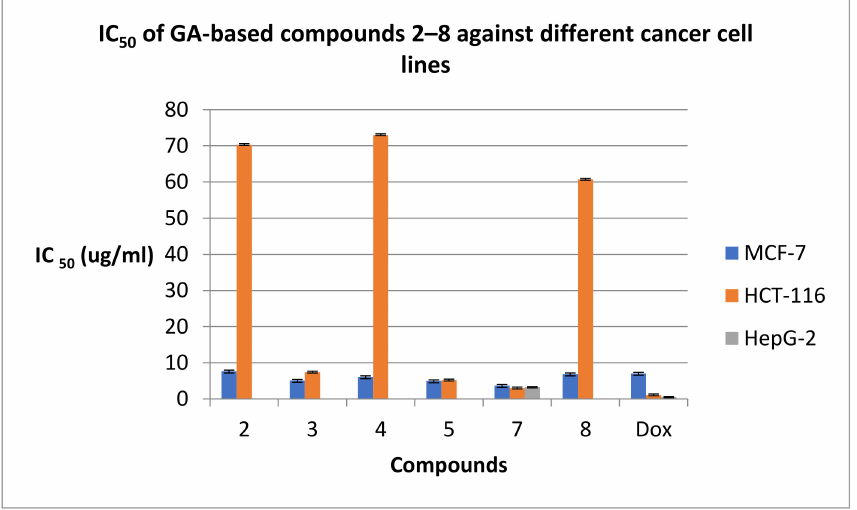
Figure 3. IC 50 values of GApeptides 2 – 8 against various human cancer cell lines.